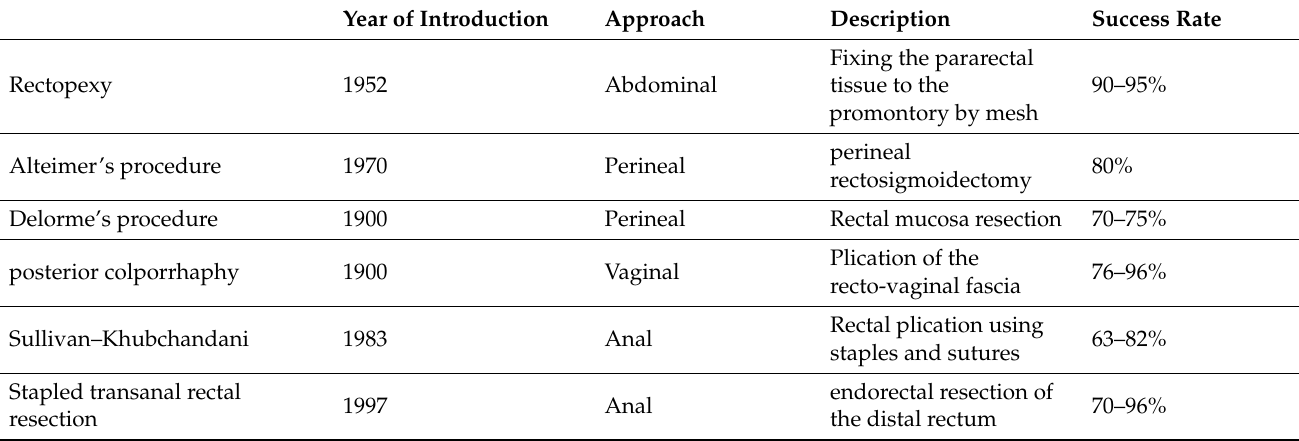
Table 1. Surgical procedures to correct rectocele